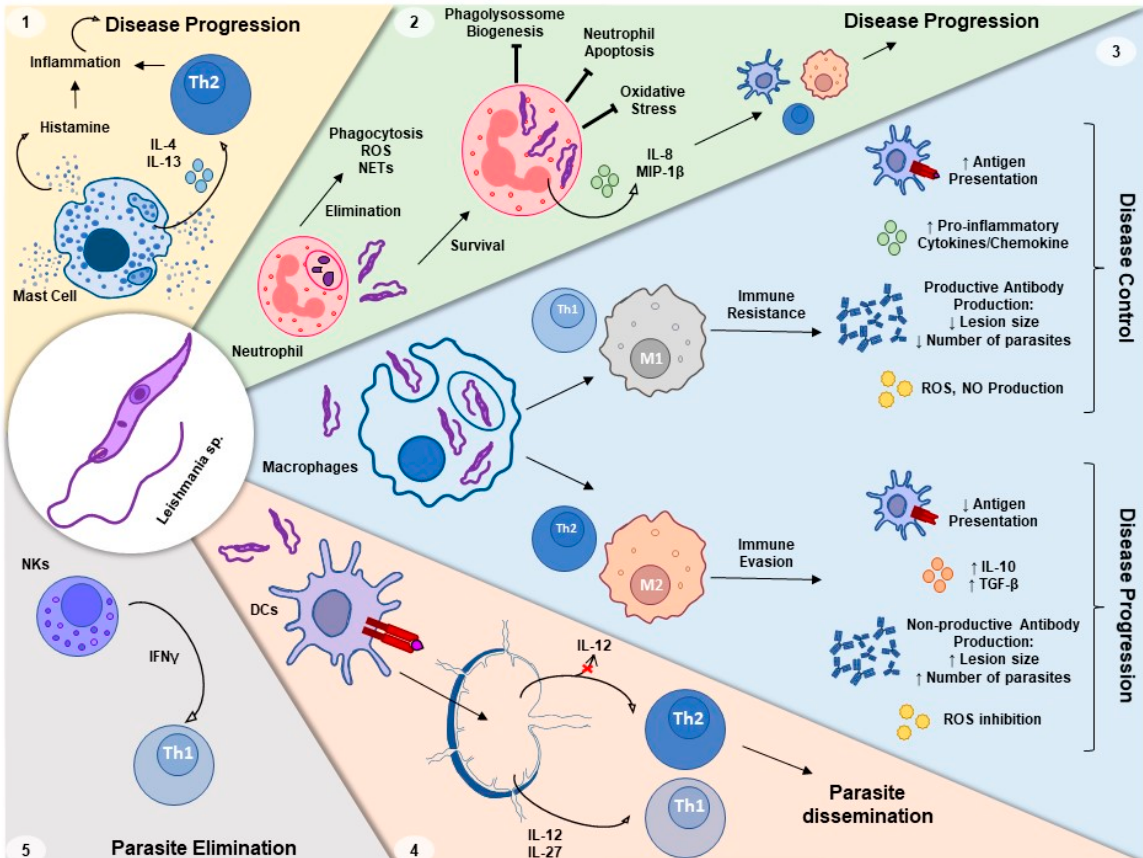
Figure 1. Impact of Leishmania infection on immune cells. Leishmania spp. interacts with multiple innate immune cells modulating their phenotype and function, as well as the adaptive immune responses. Mast cells collaborate in disease progression by secreting IL-4 and IL-13 fostering Th2 responses and parasite survival (panel 1). Neutrophils, macrophages, and DCs can either eliminate or promote parasite survival. Recruited neutrophils eliminate leishmanial parasites through phagocytosis, ROS, and NETs release. Leishmania can survive transiently within neutrophils by